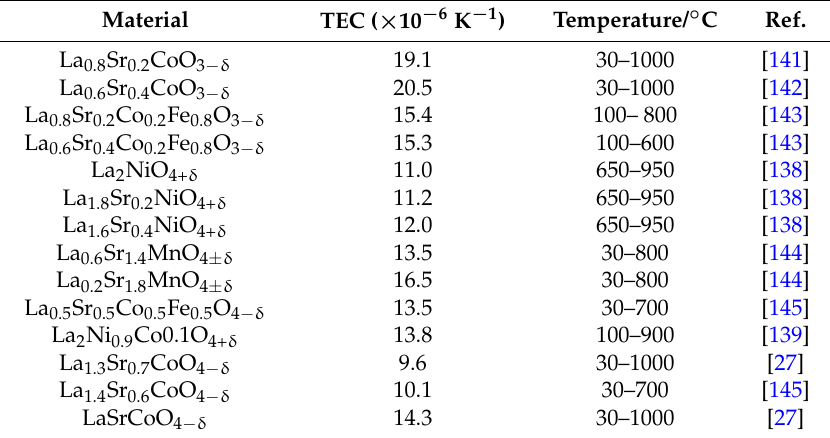
Table 4. Thermal expansion coefficients (TEC) of ABO 3 − δ and A 2 BO 4 ± δ .